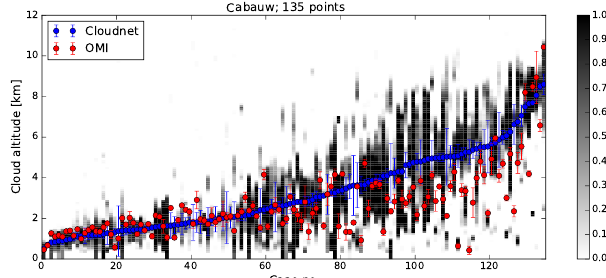
Figure 10. The effective cloud altitude retrieved from OMI (red), compared to radar–lidar cloud information for Cabauw (blue), the Netherlands. The grey background is the vertically resolved cloud occurrence derived from the radar–lidar data for the period ± 30min of the OMI overpass. The cases are ordered according to the ground station cloud